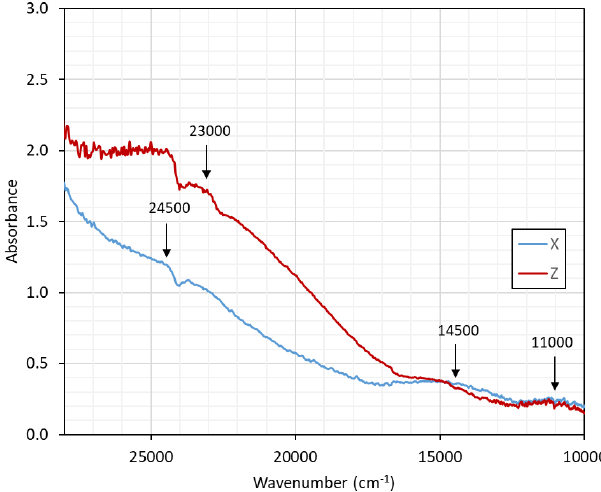
Figure 7. Polarized single-crystal optical spectra of ferri-taramite.